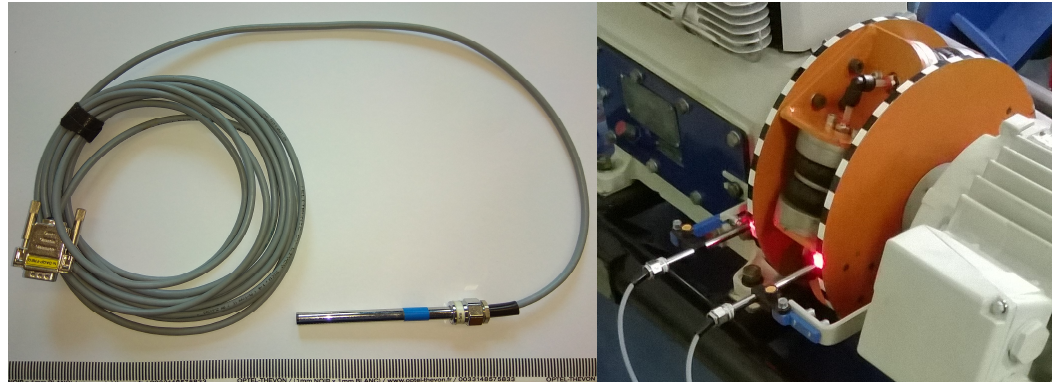
Figure 6. Optoelectronic sensors Dewetron SE-TACHO-PROBE-01 : ( a ) sensor attached to a data cable; ( b ) pair of sensors mounted in the experimental torsional oscillating mechanical system. The number of black and white stripe pairs for the driving and driven hubs should be equal and chosen with respect to the maximum twist angle of the PTTO and to the character of the transmitted load torque (especially its dynamic component). It is also important that the length of all the black and white stripes should be equal. The angle corresponding to length of a black and white stripe pair must be larger than the maximum twist angle of the PTTO. For the PTTO type 4-2 / 70-T-C , the maximum twist ◦ angle is 11 which corresponds to a maximum of 32 pairs of stripes. Further, as the major harmonic component for a three-piston compressor is the 3rd harmonic component, it is advantageous to select the number of black and white stripe pairs as integer multiples of 3 to obtain the best results for the twist angle time course by the equal operation of all cylinders (theoretically “3 identical recorded curve portions in one revolution”). Therefore, 30 black–white stripe pairs for each hub of the PTTO have been selected. The edge-crossing times t i need to be measured, where the index i stands for the sample order number. In our case, only the black-to-white stripe edges are considered. The times t i are computed from the counted number of impulses from the counter of the MFEM microprocessor. One impulse represents a time of 1 / 14745600